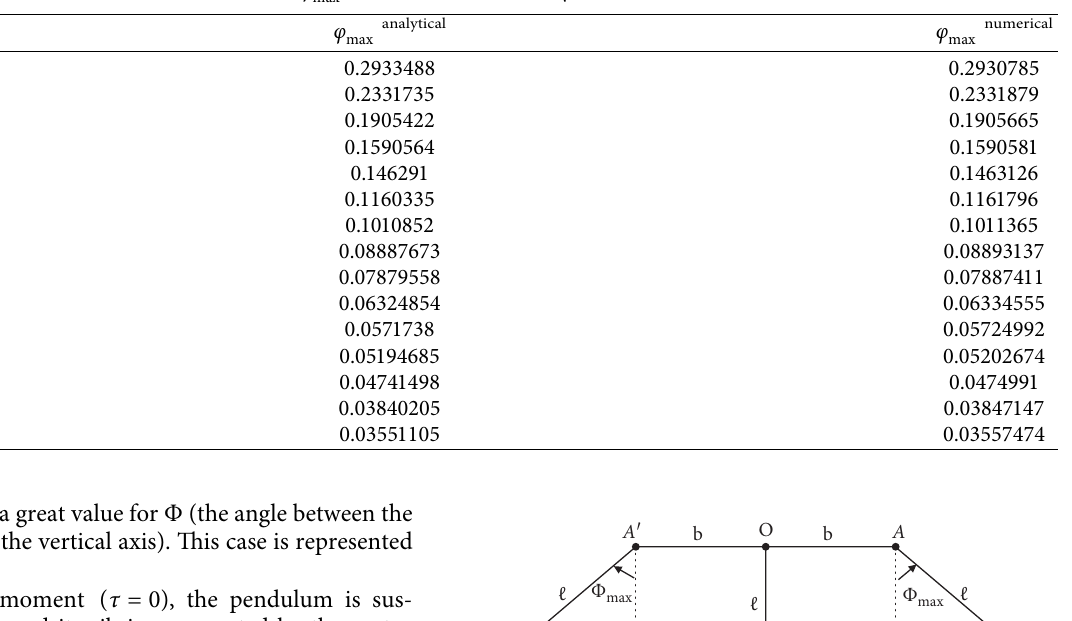
Table 1: φ of the first case ( ] � 0 , μ � 5000 ) . max